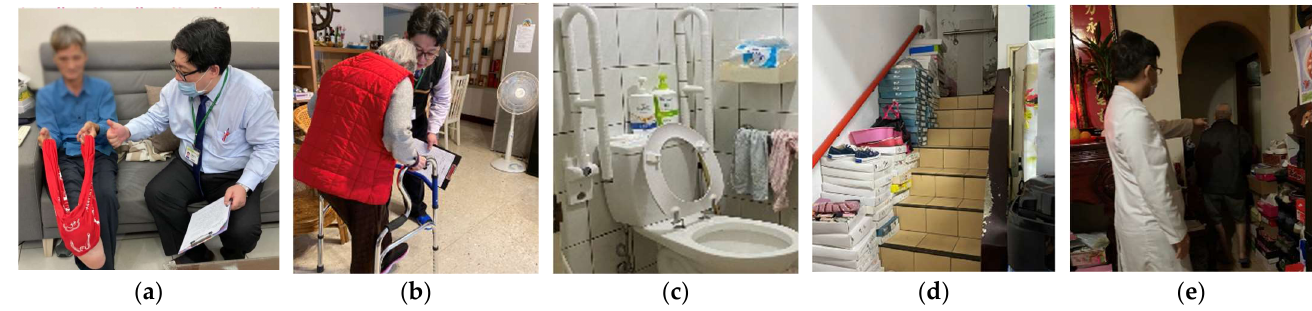
Figure 2. Home visits for patients with hip fractures. ( a , b ) Instructing patients about home-based exercise; ( c ) protective device in the living environment, grab bars in the bathroom; ( d ) hazard in the living environment, obstacles on pathway; ( e ) environmental hazard, inadequate light.